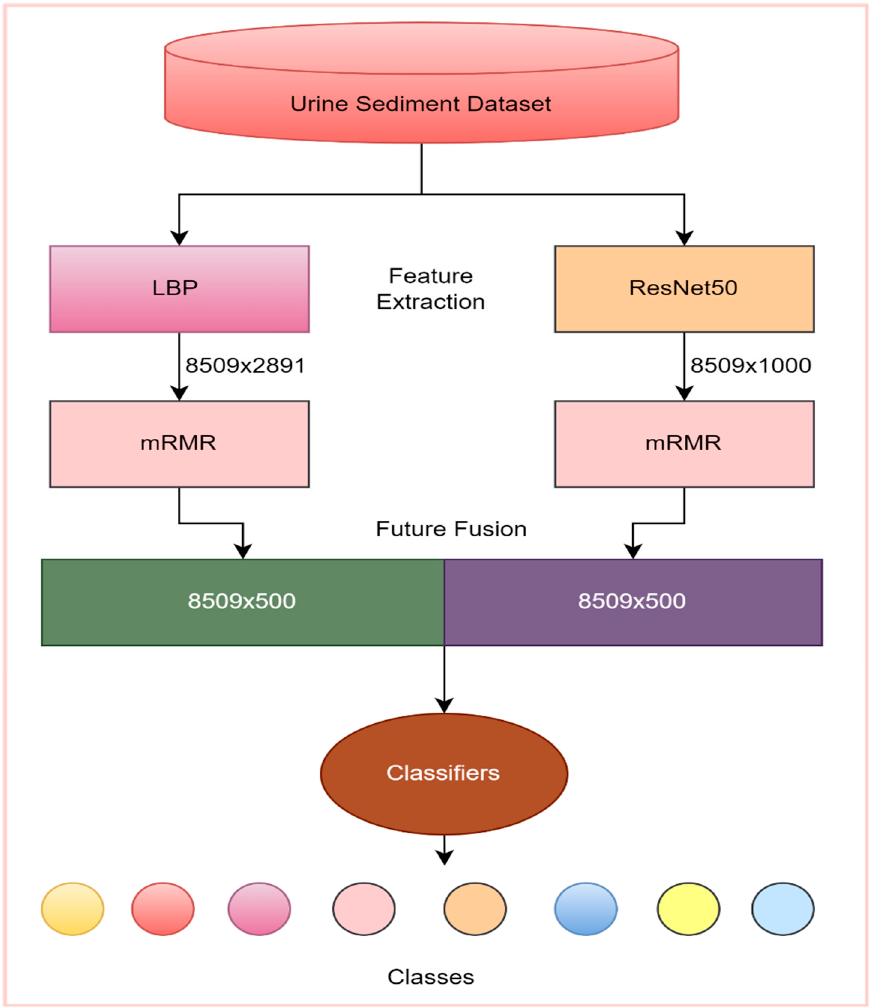
Figure 10. Flow chart of the proposed model.